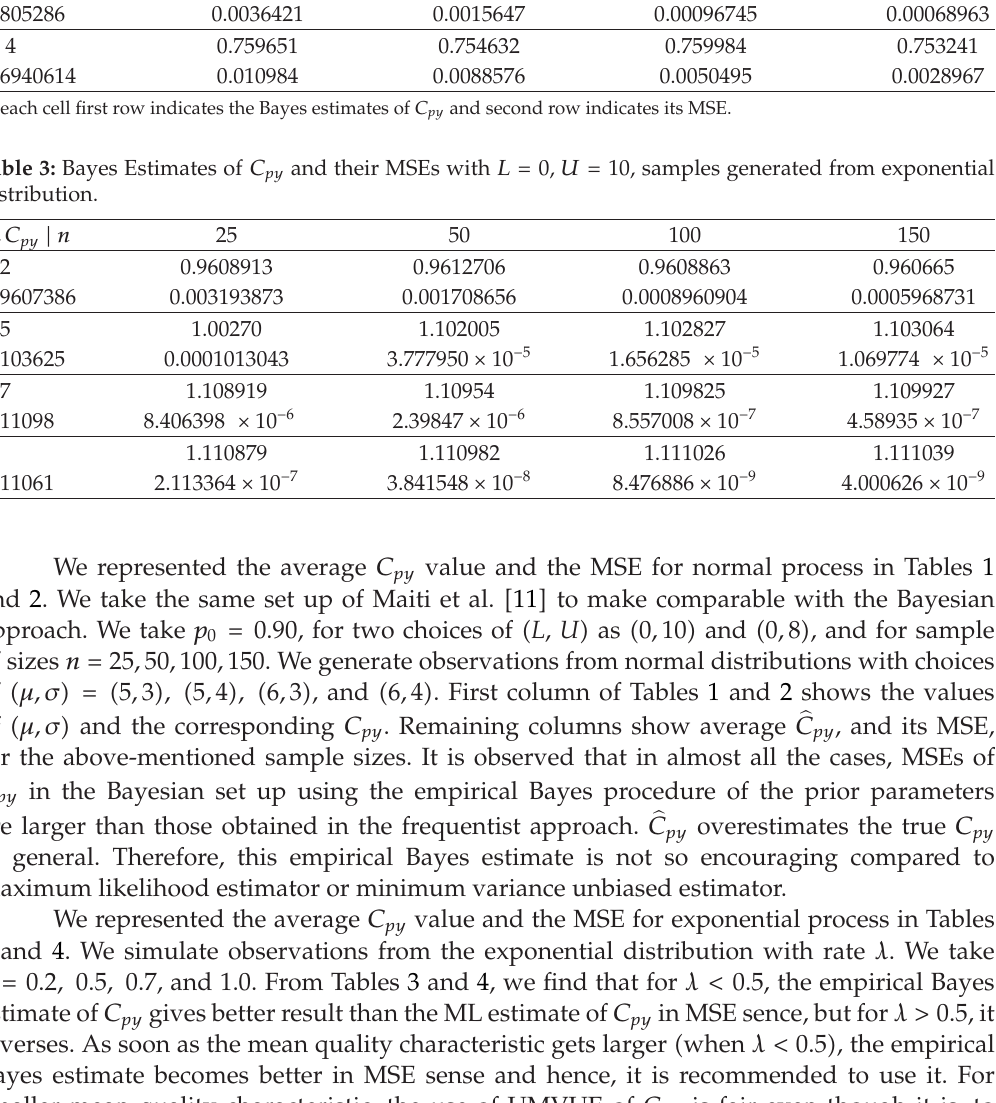
Table 3: Bayes Estimates of C